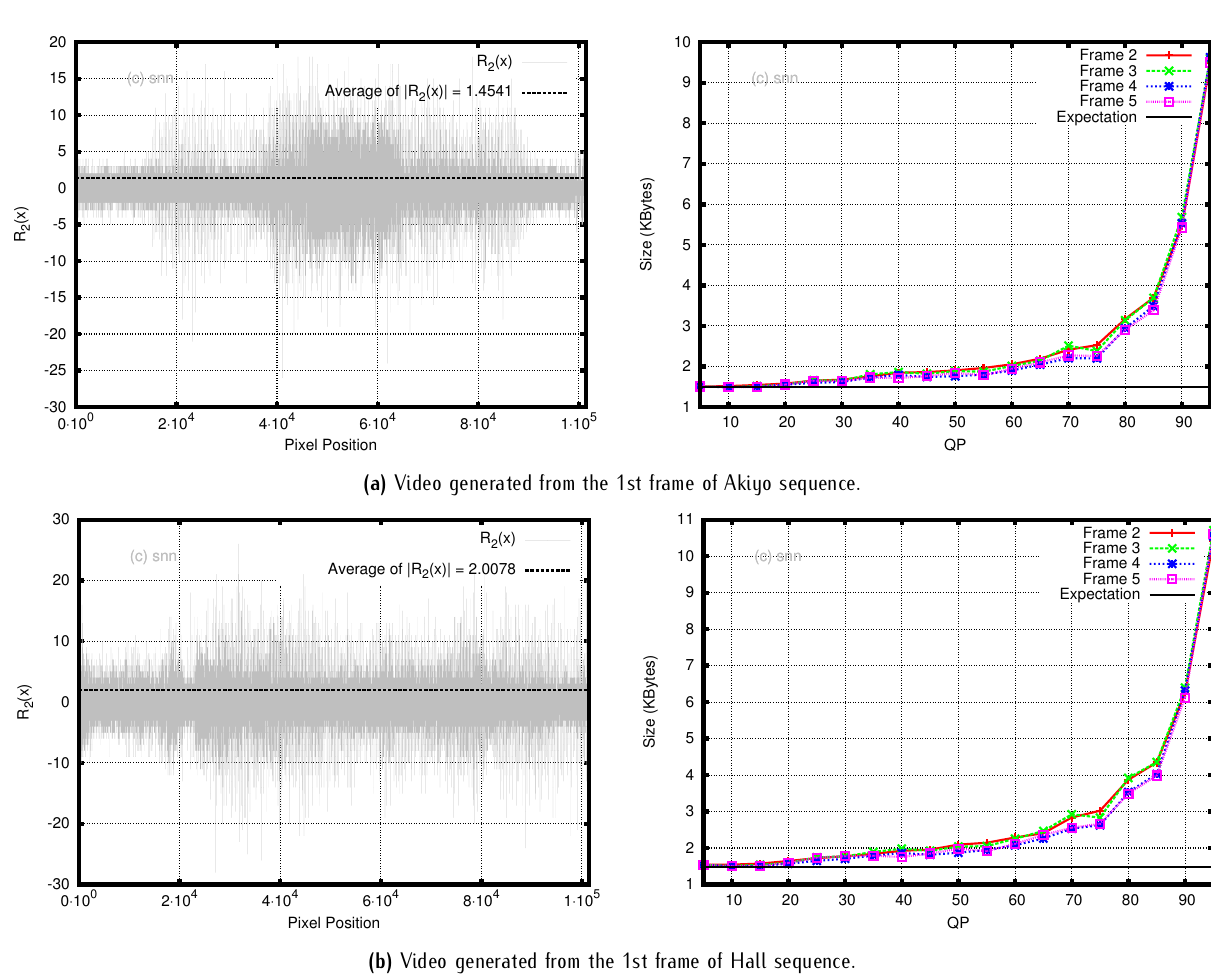
(b) Video generated from the 1st frame of Hall sequence. Figure 3. Residual error (left side) and bitstream size (right side) results of the test case in Figure